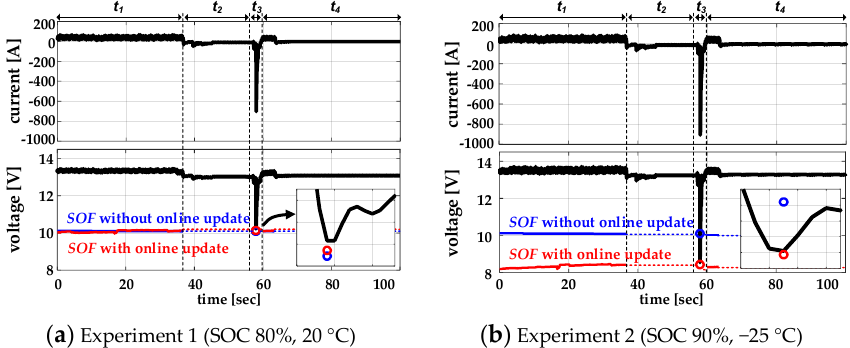
Figure 16. Experimental verification results. Table 2. Cranking experiments and SOF estimation results.